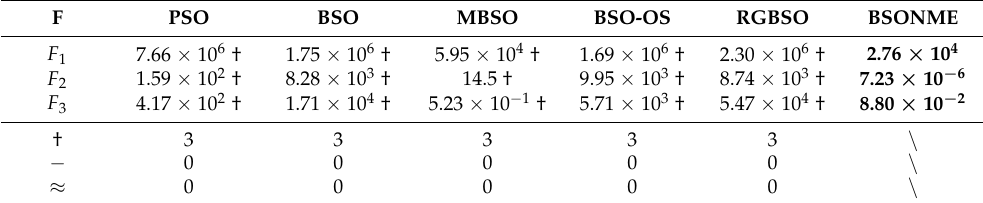
Table 5. Experimental results of PSO, BSO, MBSO, BSO-OS, RGBSO, and BSONME on F 1 – F 3 .